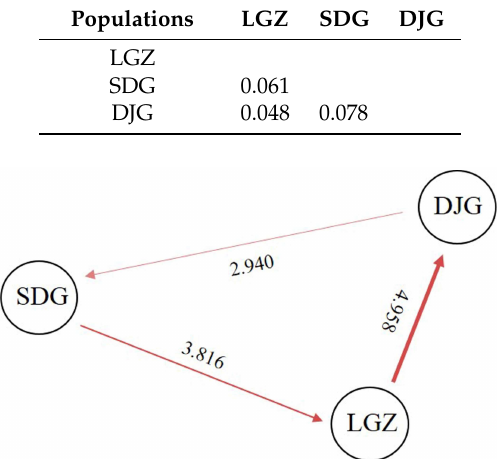
Table 7. Pairwise genetic differentiation index ( F st ) values between the three populations. Populations